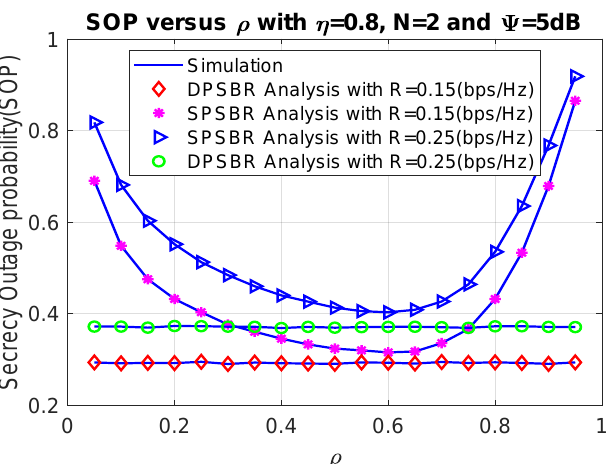
Figure 4. Outage probability versus ρ .